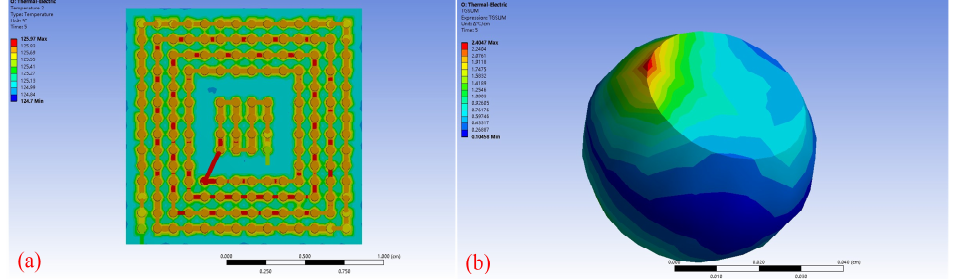
Figure 5. Simulation results of the temperature ( a ) Temperature distribution in D501 ( b ) Temperature gradient in solder joint.